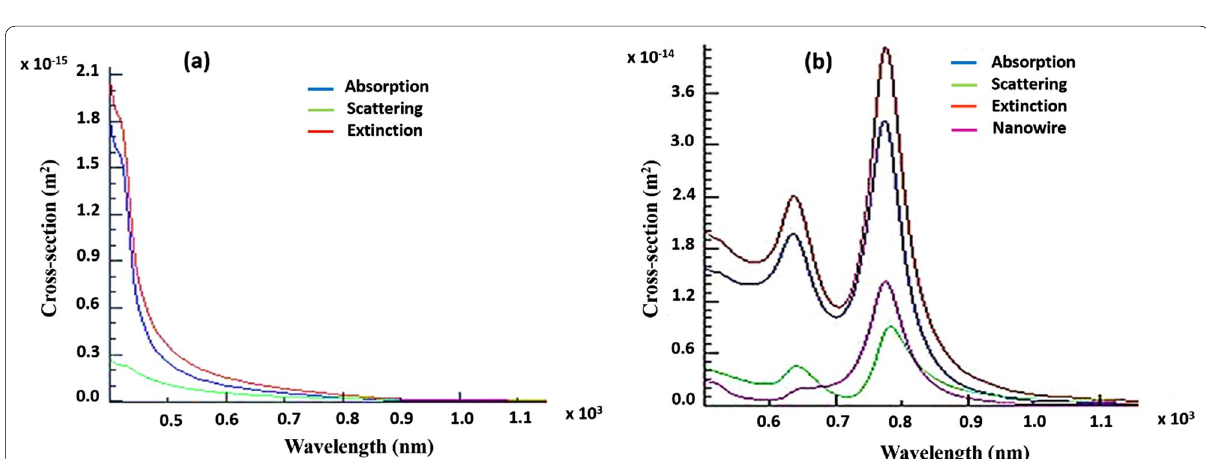
scattering) for bare GaAs NW a under perpendicular illumination and +